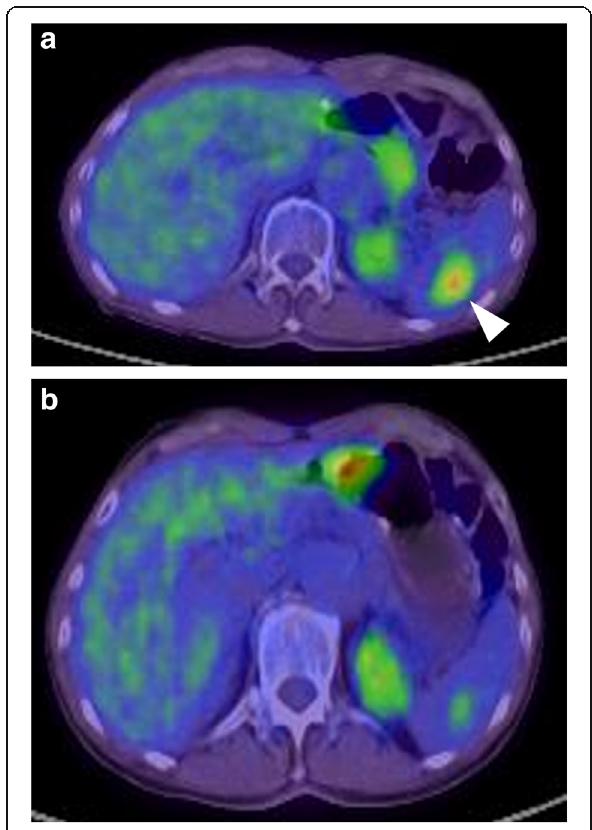
Fig. 3 a The PET/CT shows intense fluorine-18 fluorodeoxyglucose (18F-FDG) uptake with a maximum standardized uptake value (SUV) of 5.82 (arrowhead) at the spleen. b Retrospectively, preoperative PET/CT shows very faint uptake (maximum SUV, 4.76) at the spleen